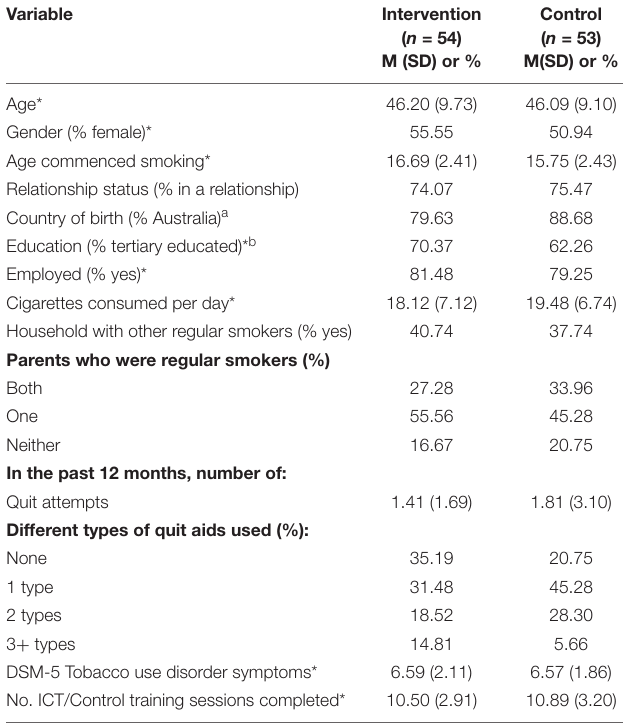
TABLE 1 | Demographics of participants at